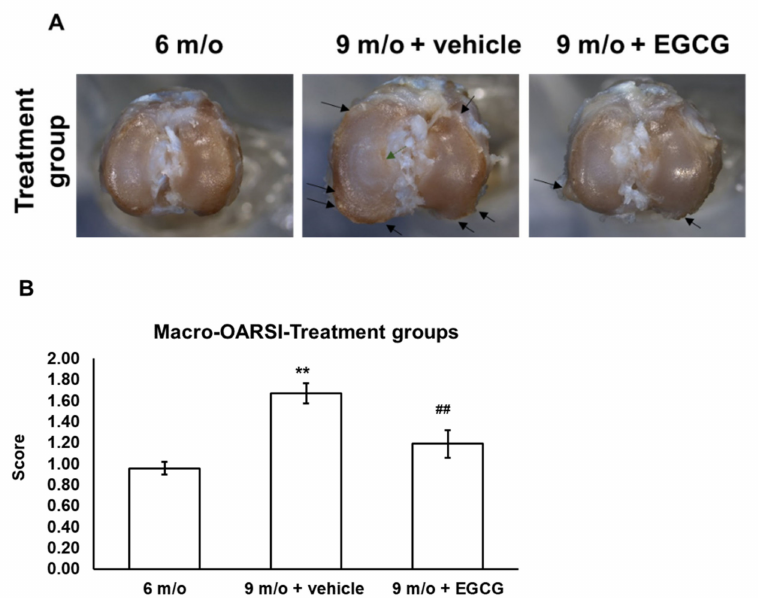
Figure 5. Macroscopic view of right tibial plateau of samples ( A ) and OARSI macroscopic scoring ( B ) between groups, including 6-month-old animals, 9-month-old animals treated with PBS, and 9-month-old animals treated with EGCG. The cartilage surface (especially the medial tibial plateau) of animals became rougher, and there was more severe erosion in the cartilage samples at 9 months of age. Osteophyte formation over the margin of the tibial plateau was also observed in the cartilage samples at 9 months of age than was noted found in the cartilage sampled at 6 months of age. There was less cartilage erosion and osteophyte formation and lower macro-OARSI scores after EGCG treatment ( n = 8 in each group; ** p < 0.01 versus animals at 6 months of age; ## p < 0.01 versus the animal treated with PBS at 9 months of age).